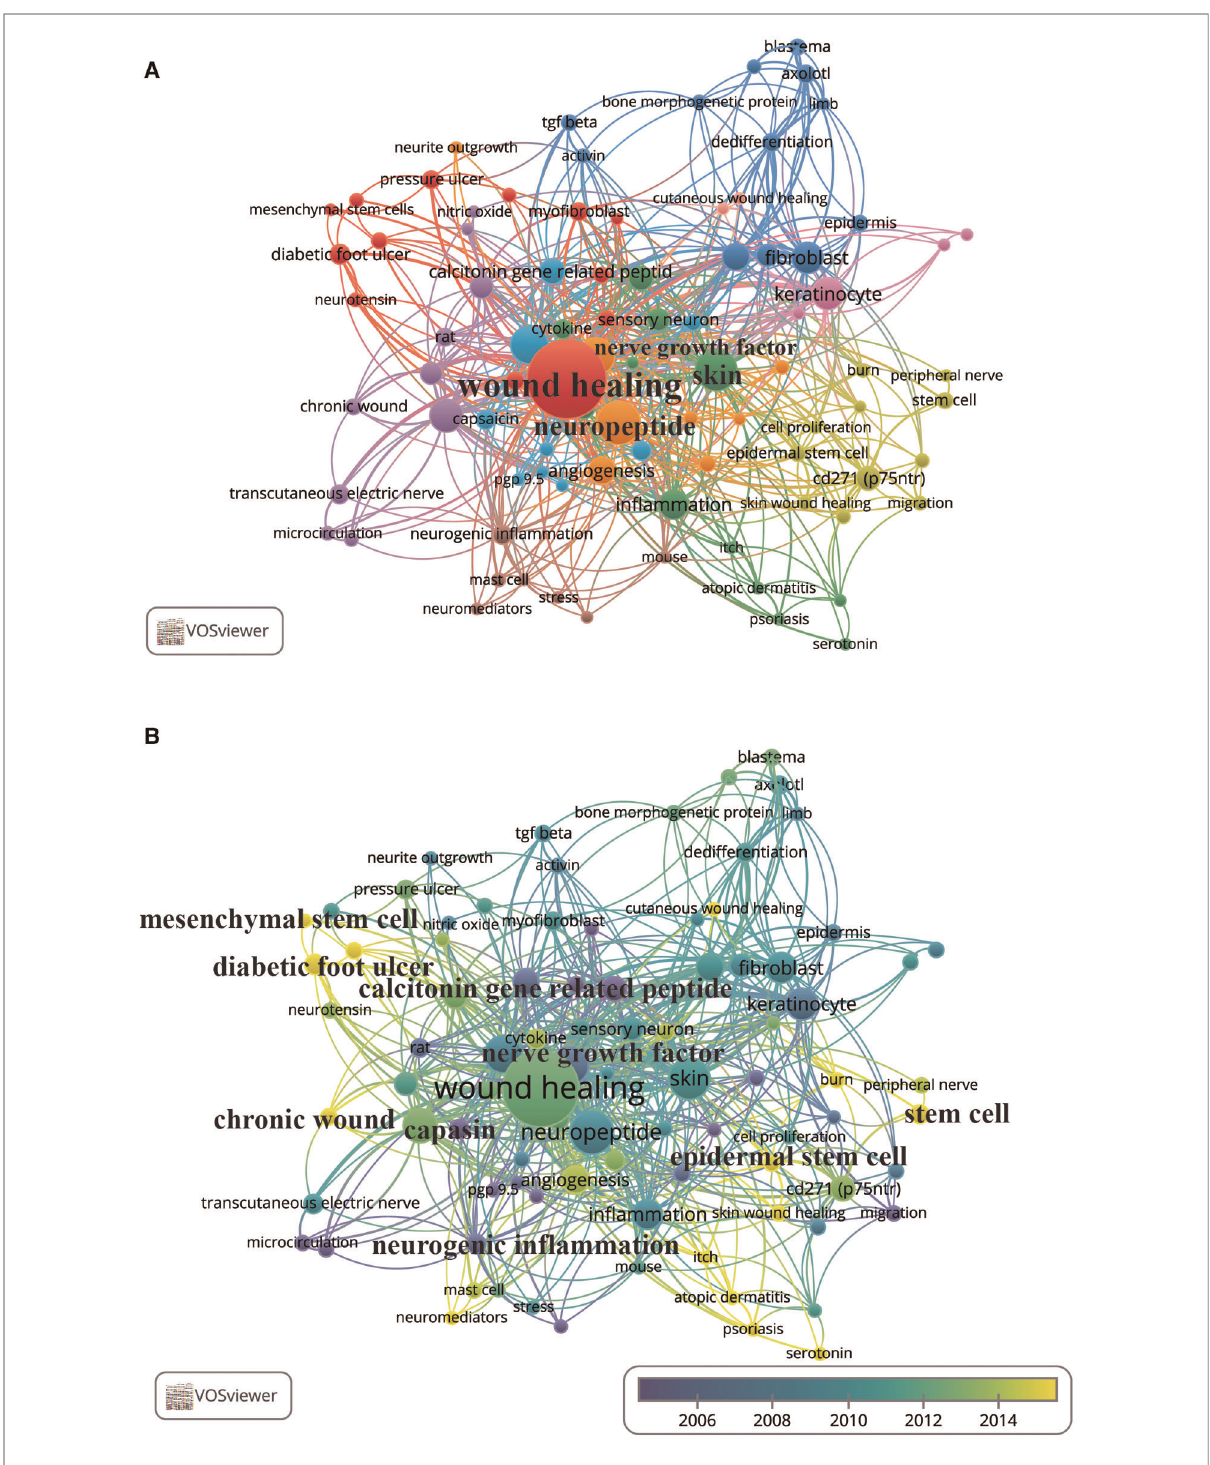
FIGURE 9 Co-occurrence networks of author keywords. Each node represents an author keyword, and each line represents a link between two author keywords. The size of each node represents the author keyword occurrence, and the thickness of each line represents the strength of the link. ( A ) Co-occurrence network map of the 88 author keywords that occurred at least three times. The colour of each node represents the clusters of author keywords. ( B ) Author keyword co-occurrence time-overlay map of the co-occurrence networks of the 88 author keywords that occurred at least three times. The colour of each node represents the average publication year, according to the colour gradient presented in the lower right